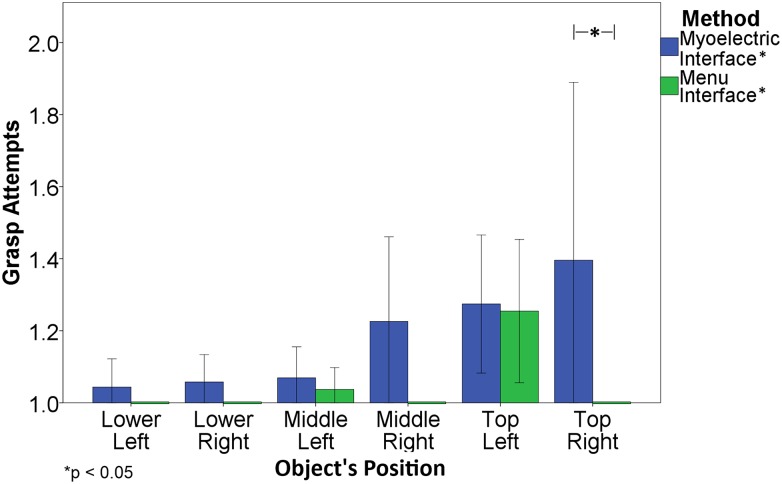
GA performance results for the different object’s position.1 grasp attempt was the minimum possible value for this measurement. The error bars indicate the standard error.